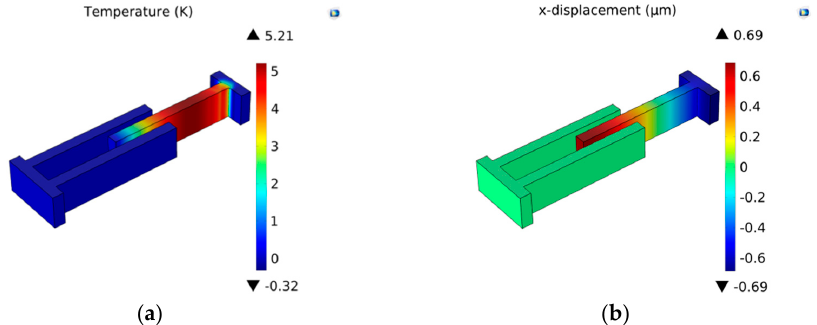
Figure 9. The temperature variation and displacement distributionfor longitudinal vibration without electrostatic load: ( a ) temperature variation; ( b ) displacement distribution. Sensors 2016 , 16 , 1445